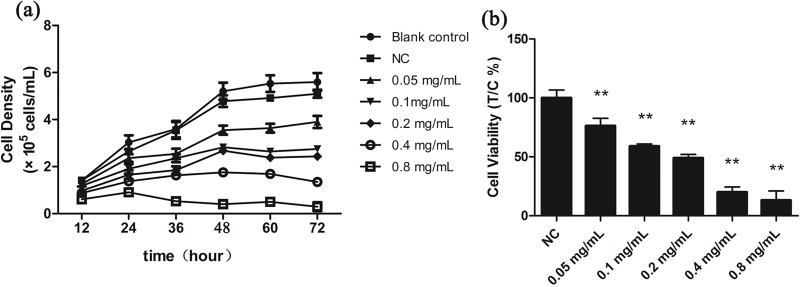
The effect of koumine on T. thermophila growth after various levels exposure.(a) T. thermophila growth in the presence of koumine for 72h. (b) T. thermophila viability after koumine exposure for 24h. Data are expressed as mean ± SD (n = 3). * indicates significant differences (P < 0.05), ** indicates highly significant differences (P < 0.01). Blank control, no drug addition. NC, Negative control (0.1% DMSO). All treatment groups were compared to the NC group.